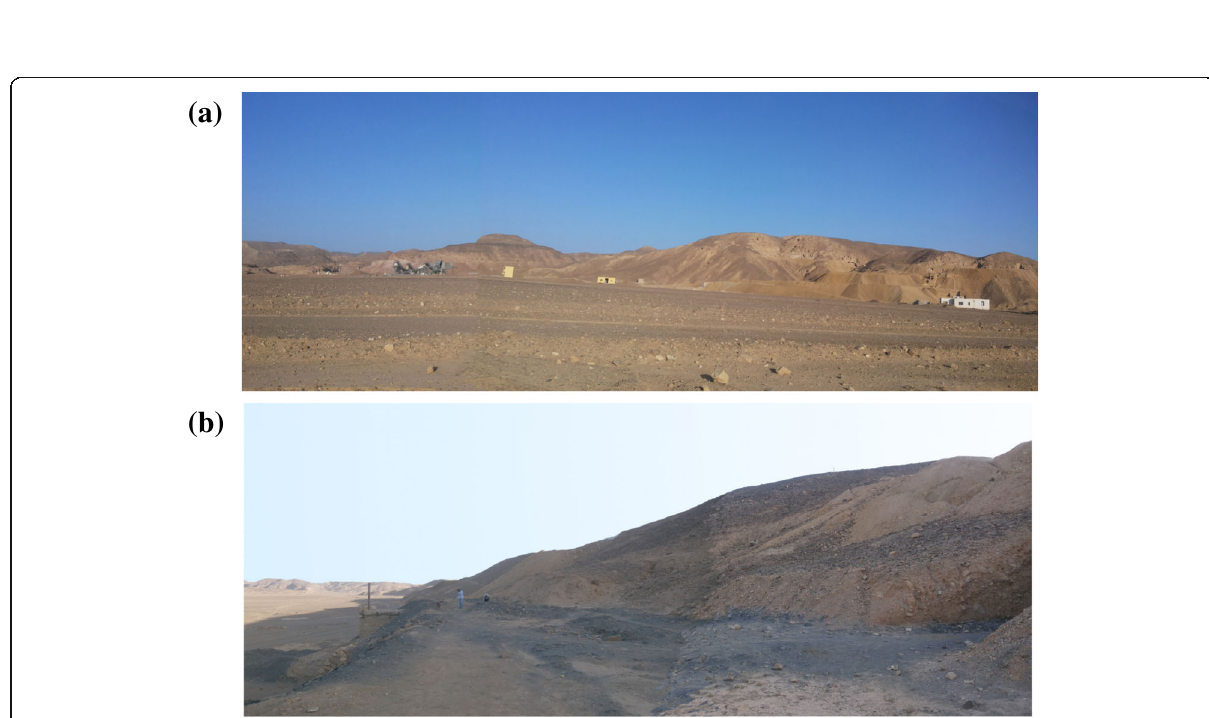
Fig. 2 Field photography of the studied area. a Recent Yunis active mining surface quarry. b Waste clay ramp of Yunis abandoned mining